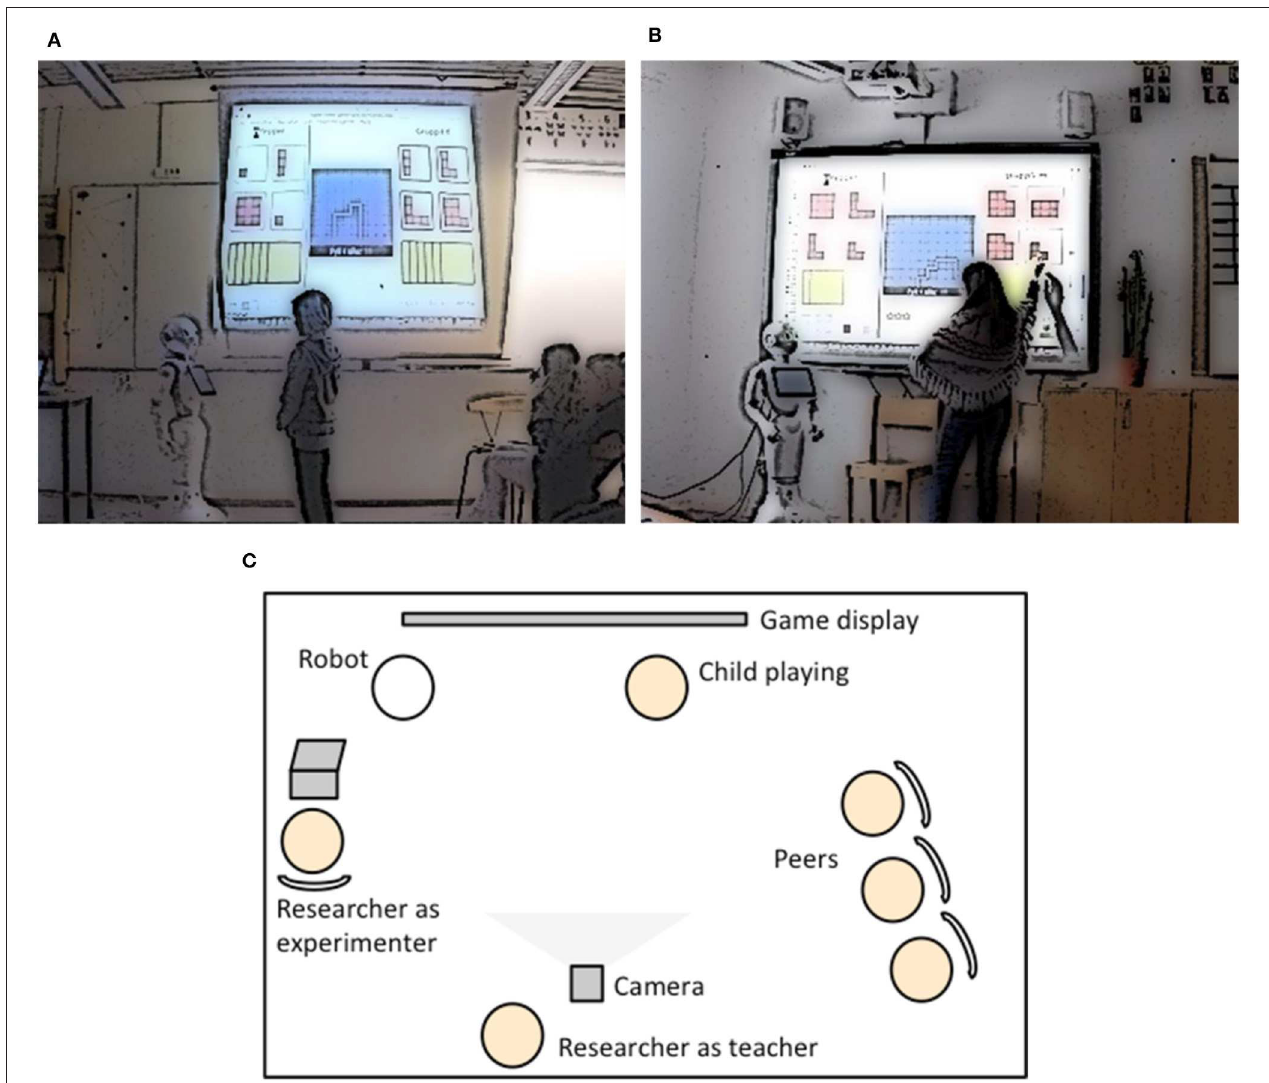
FIGURE 1 | (A) Still image of the field trial setup at School A. (B) Still image of the field trial setup at School B. (C) Top-view illustration of the field trial